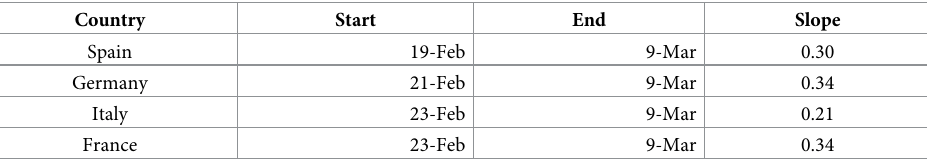
Table 1. Initial exponential growth r from estimates in bold from Table 1 of